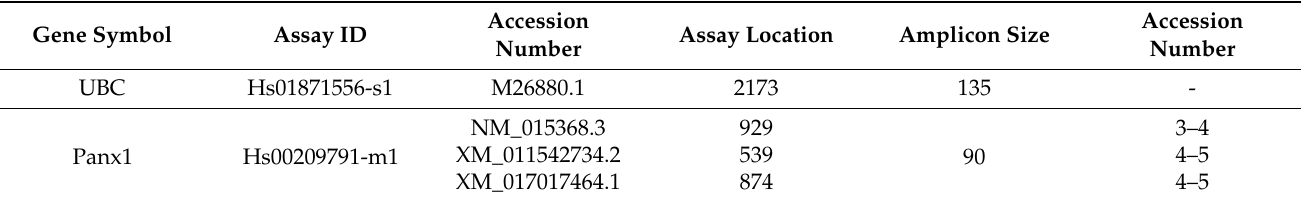
Table 2. Primers and probes for RT-qPCR analysis. (Panx1 (pannexin1); UBC (ubiquitin